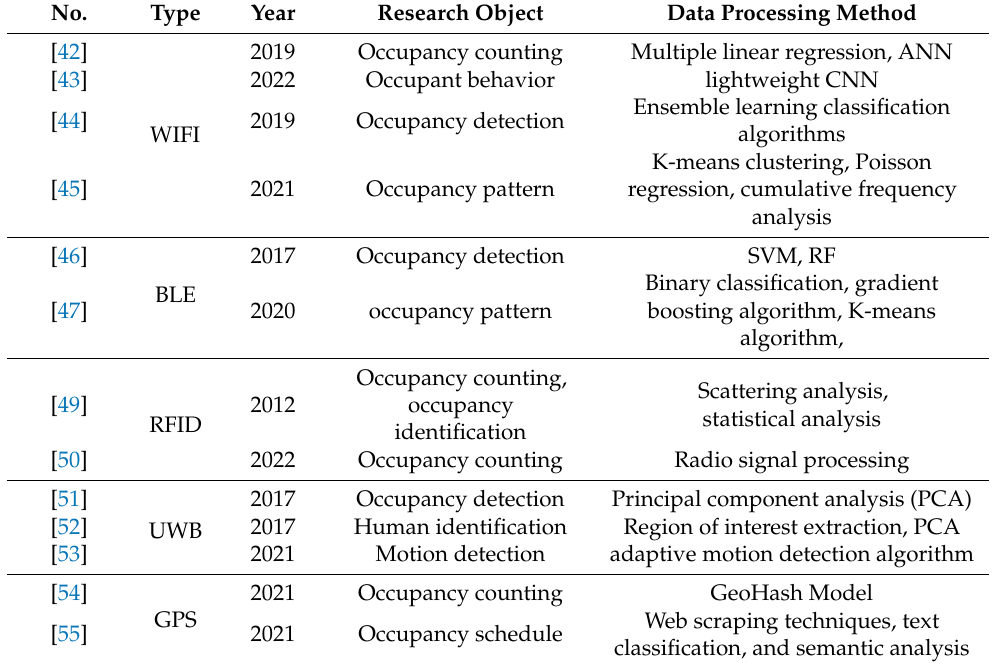
Table 3. The list of references for radio frequency signal-based sensing.